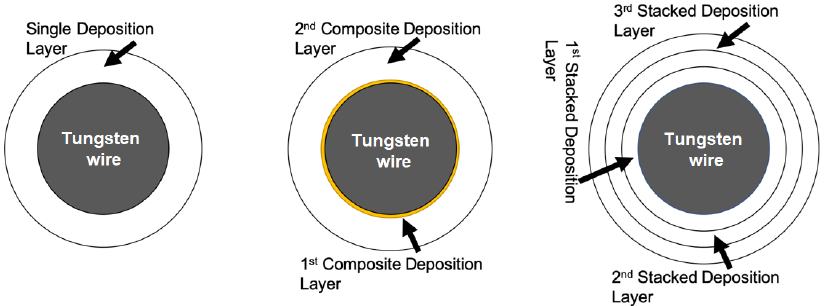
Figure 1 . Schematic diagram of the three wire packaging categories . Figure 1. Schematic diagram of the three wire packaging